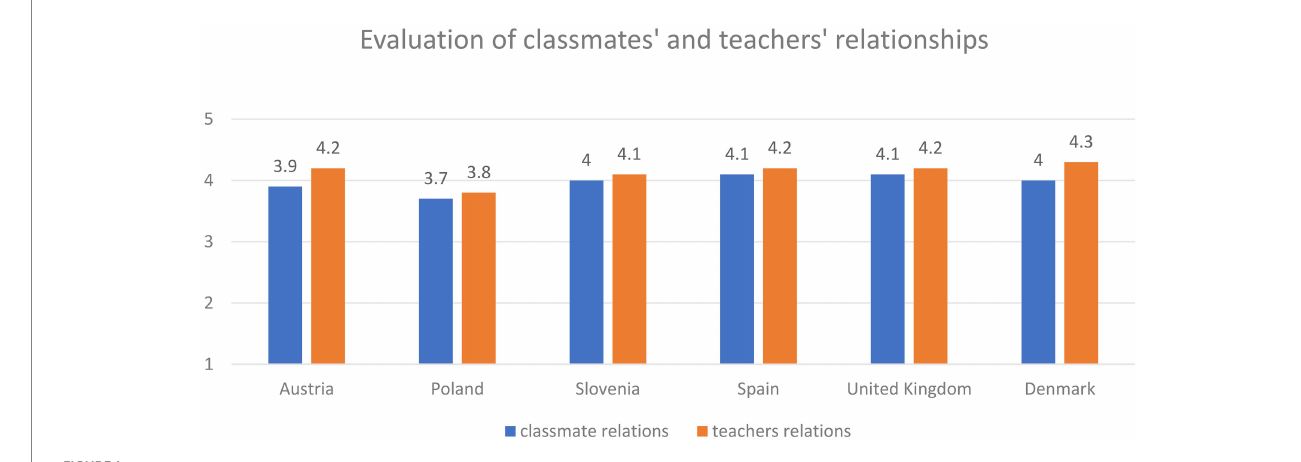
FIGURE 1 Evaluation of classmates’ and teachers’ relationships.